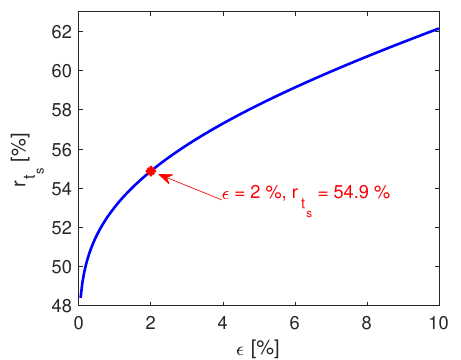
Figure 6. Settling-time ratio between second-order and first-order filters.